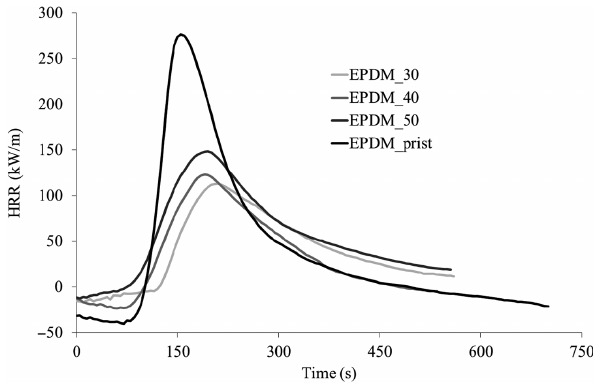
Figure 4: Heat release rate (HRR) curves of samples studied.